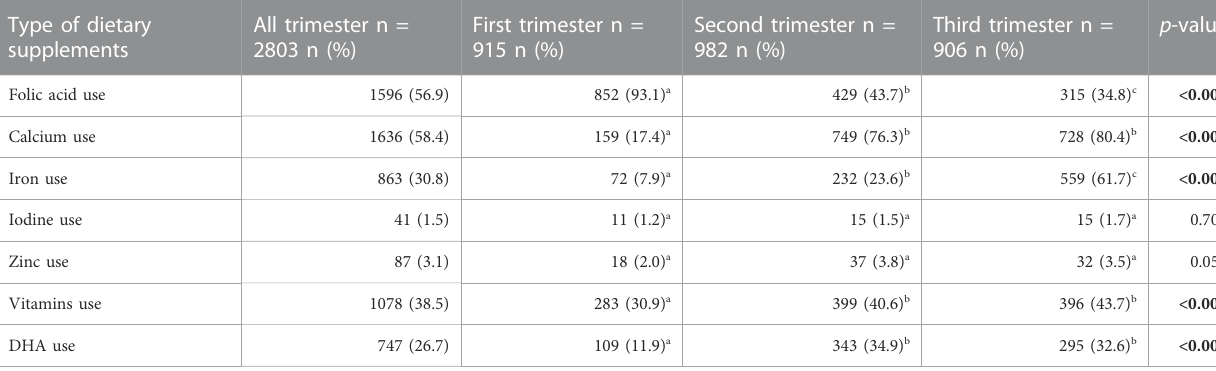
TABLE 3 Trimester-speci fi c dietary supplement use (N =